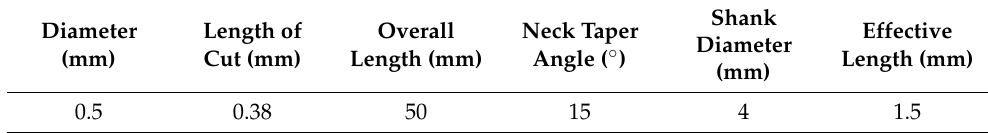
Table 3. Geometric parameters of the micro-milling tool.